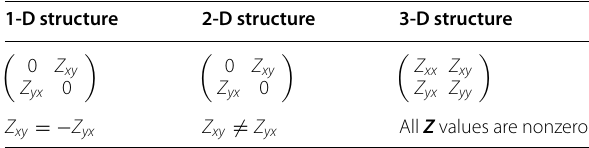
where the brackets represent the averages of N indi- vidual autopower spectra and cross-power spectra. For instance,